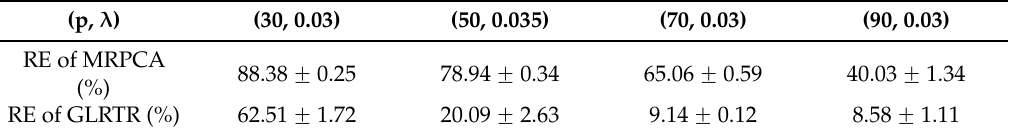
Table 4. Comparison of experimental results on incomplete 20 ˆ 20 ˆ 20 ˆ 20 tensors for r = 4.